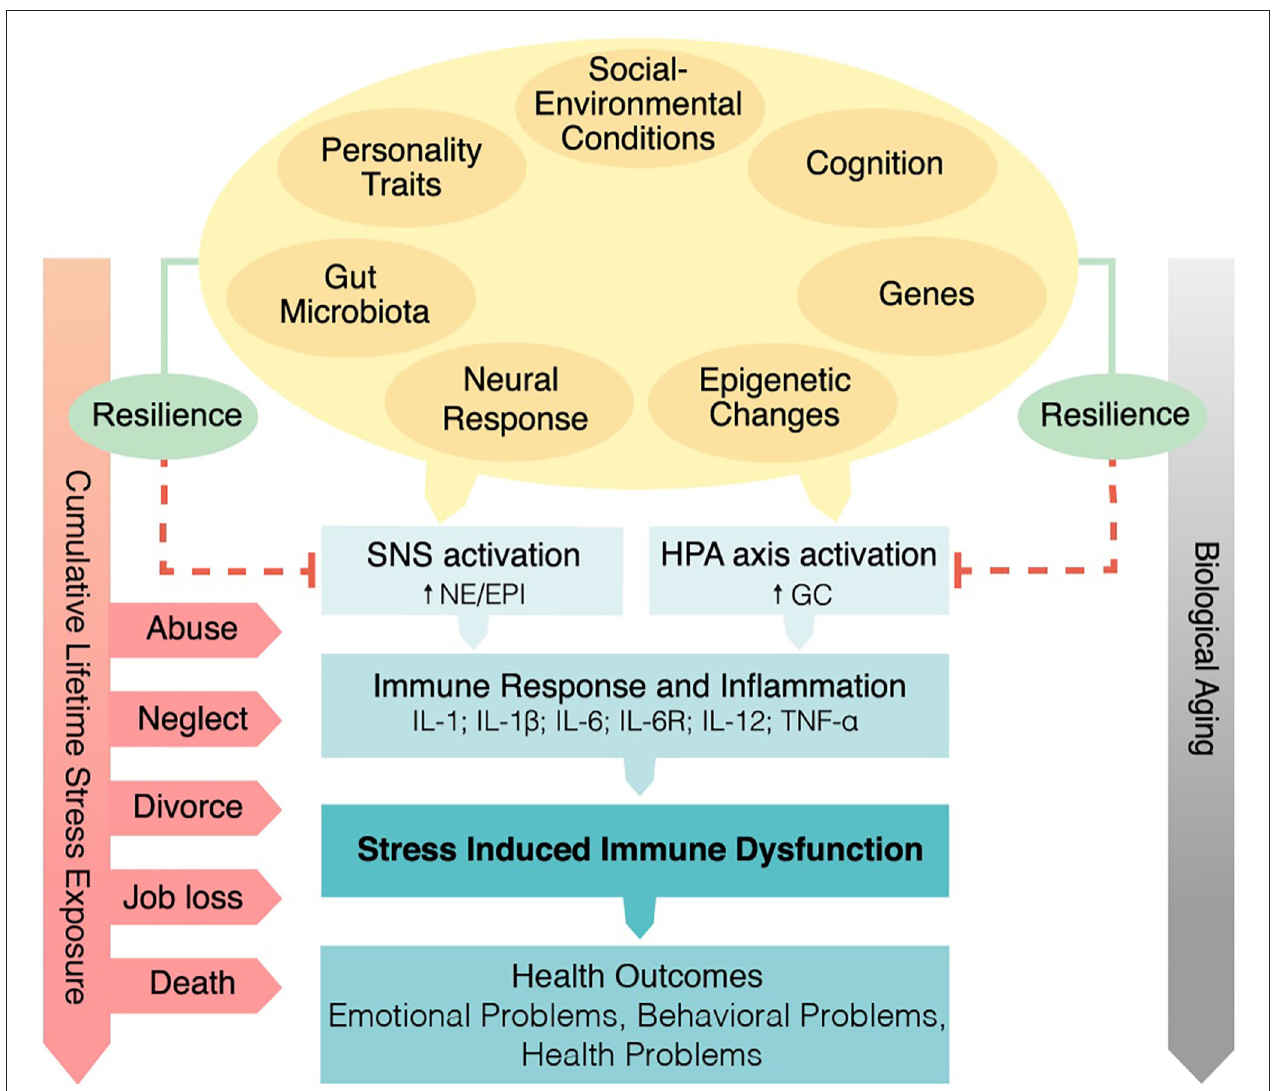
FIGURE 1 | Psychobiological mechanisms linking spousal bereavement and health from the perspective of the Social Signal Transduction Theory of Depression (20). The interplay between genetic factors, personality traits (e.g., neuroticism), and social-environmental conditions during childhood and adolescence (e.g., social/financial stress, uncertainty, abuse, or neglect) are hypothesized to play important roles in shaping individuals’ neuro-inflammatory sensitivity to later-occurring life stressors, including interpersonal loss. Exposure to early life stress and subsequent stressors are hypothesized to heighten sympathetic nervous system and hypothalamic-pituitary-adrenal axis dysregulation, and to promote increased inflammatory activity in response to a significant loss. If chronic, elevated inflammatory activity can in turn lead to a variety of adverse emotional, behavioral, and health outcomes. SNS, sympathetic nervous system activation; NE, norepinephrine; EPI, epinephrine; HPA, hypothalamic-pituitary-adrenal; GC, glucocorticoid; IL-1, interleukin-1; IL-1 β , interleukin-1beta; IL-6, interleukin-6; IL-6R, interleukin-6 receptor; IL-12, interleukin-12; TNF- α , tumor necrosis factor- α